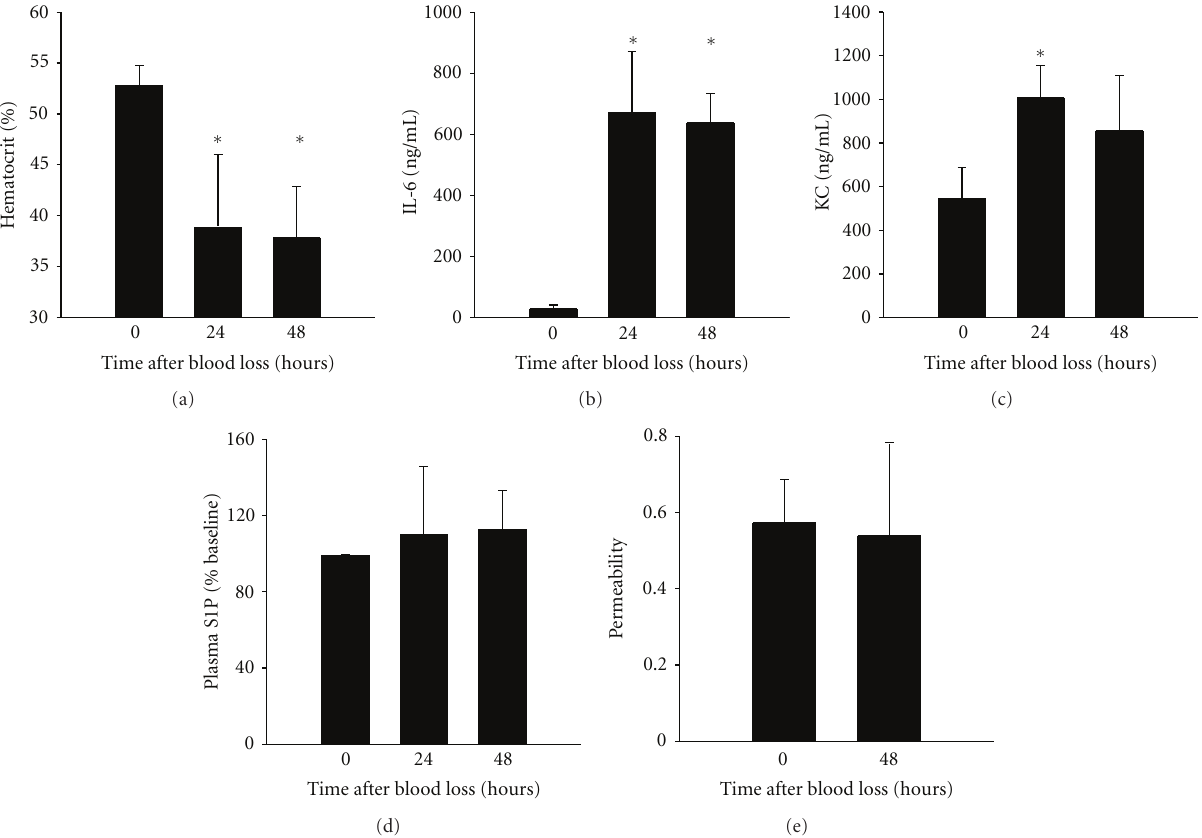
Figure 1: E ff ect of blood loss on systemic inflammation response and lung endothelial permeability. (a) Hct, (b) plasma IL-6, (c) plasma KC, and (d) plasma S1P were measured at baseline (time = 0; n = 6) or at 24 ( n = 3) or 48 hours ( n = 3) after major blood loss (0.02 mL/gm). (e) Lung permeability was measured in mice that had not undergone blood loss (time = 0; n = 3) or at 48 hours after major blood loss ( n = 3) by quantifying accumulation of IV injected EBD into the lung. Results were analyzed by one-way ANOVA (Bonferroni correction) ∗ P < 0 . 05 versus time =